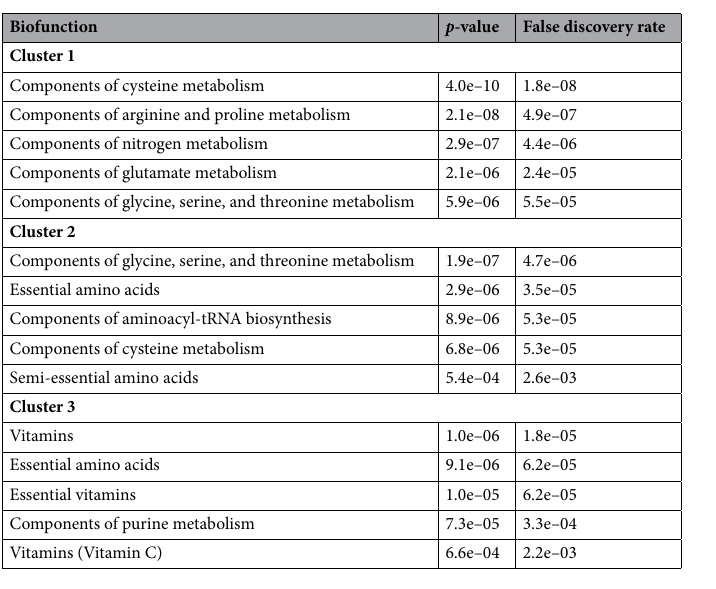
Table 3. Top five biofunctions for each cluster annotated by enrichment analysis of 68 metabolites.